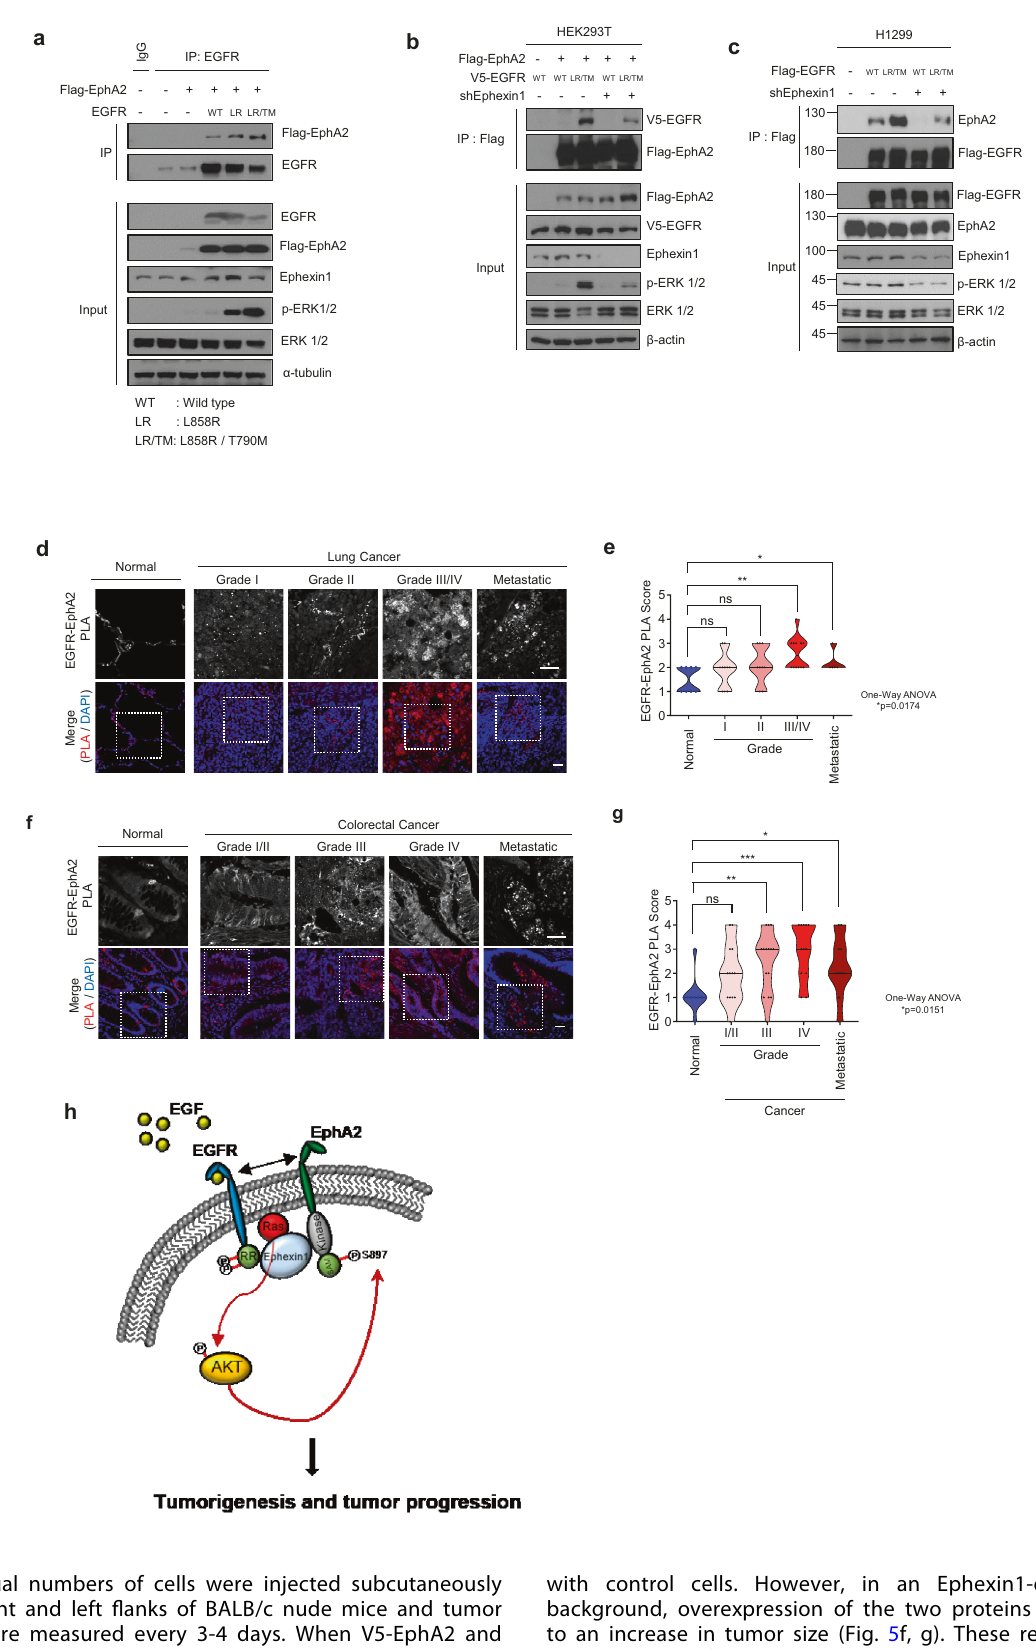
in vivo, equal numbers of cells were injected subcutaneously into the right and left fl anks of BALB/c nude mice and tumor volumes were measured every 3-4 days. When V5-EphA2 and V5-EGFR were overexpressed, tumors collected at 20 days post- injection were signi fi cantly larger than tumors that developed